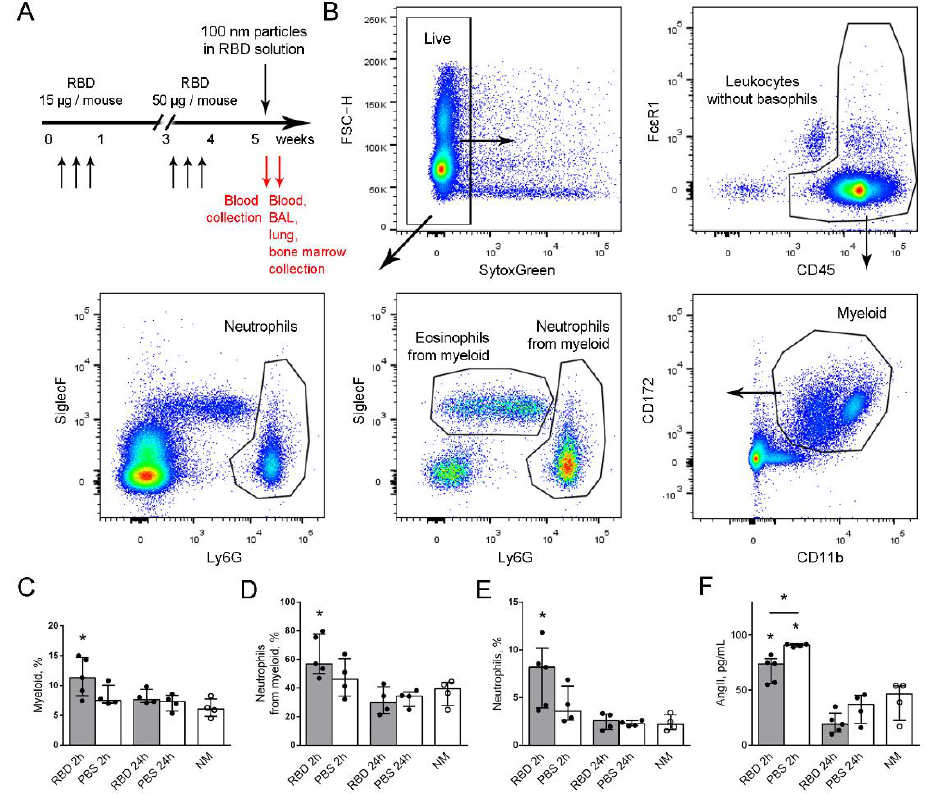
Figure 2. Neutrophil–mediated response to the application of 100 nm particles in the RBD solution. ( A ) The scheme of the RBD i.p. injections and o.ph. application of 100 nm particles in RBD solution to mice (black arrows). Two and 24 h after the o.ph application, blood was collected; 24 h after the application, BAL, lung and bone marrow were collected (red arrows). ( B ) The strategy of the neutrophil identification among blood cells or among myeloid cells. ( C – E ) The percentages of myeloid cells ( C ), neutrophils from myeloid cells ( D ) and neutrophils from live blood cells ( E ) 2 and 24 h after the o.ph. application of 100 nm particles in the RBD solution to the RBD—(gray bars, black circles) or PBS–injected mice (open bars, black circles); the intact mice NM (open bars, open circles). ( F ) The level of angiotensin II in the peripheral blood sera of mice injected with RBD (gray bars, black circles) or PBS (open bars, black circles) 2 and 24 h after the o.ph. application of 100 nm particles in the RBD solution, and the intact mice—NM (open bars, open circles). The data are shown as medians and interquartile range (i.q.r.) for n ≥ 4 mice per group. A significant difference between the indicated group and the intact mice was detected using the Mann – Whitney test *: p ≤ 0.05 .